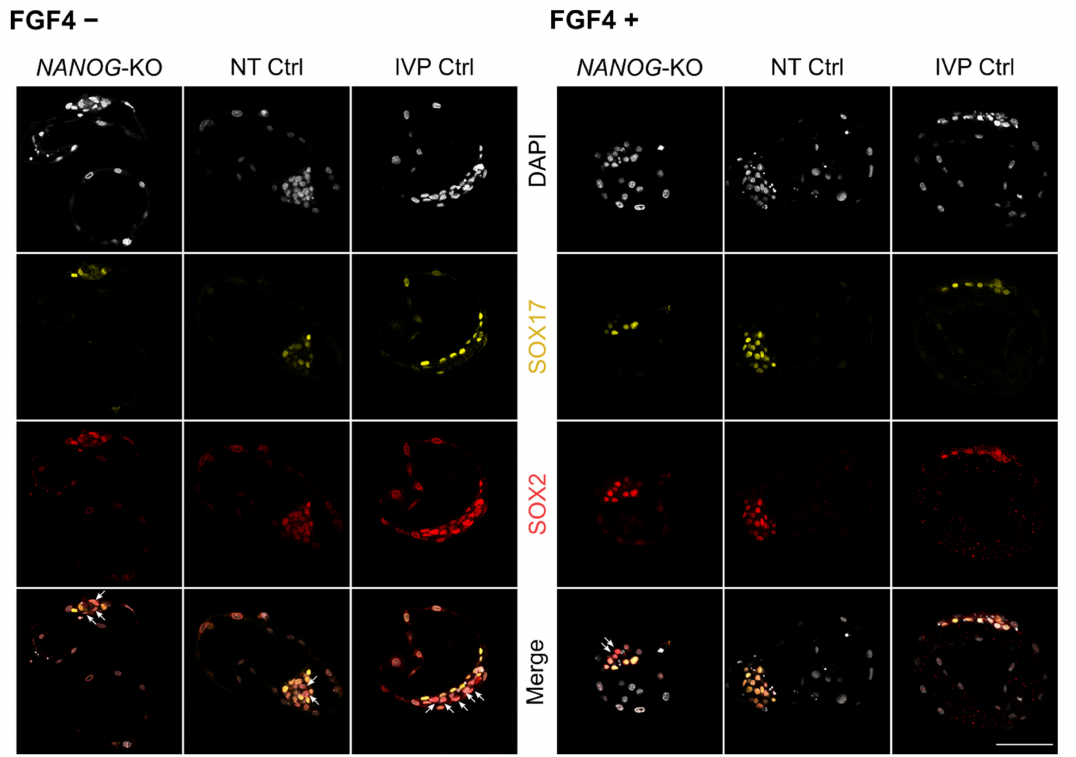
Figure 4. Expression of pluripotency and late hypoblast markers in NANOG -KO, NT Ctrl, and IVP Ctrl day 8 embryos treated with exogenous FGF4 and heparin. Representative confocal planes of day 8 blastocysts stained for SOX17/SOX2. Embryos without ( − ) and with (+) FGF4 and heparin treatment are presented. Arrows indicate ICM cells with exclusive SOX2 expression (SOX17 negative). Color codes are: Grey (DAPI), yellow (SOX17) and red (SOX2). Scale bar indicates 100 µ